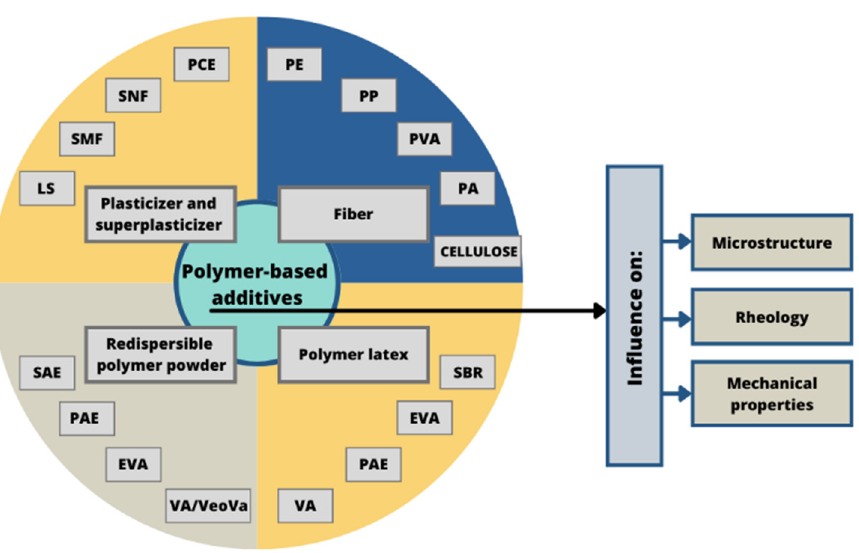
Figure 1. The scheme of the type of additives and the changes they cause in concrete-based compo-